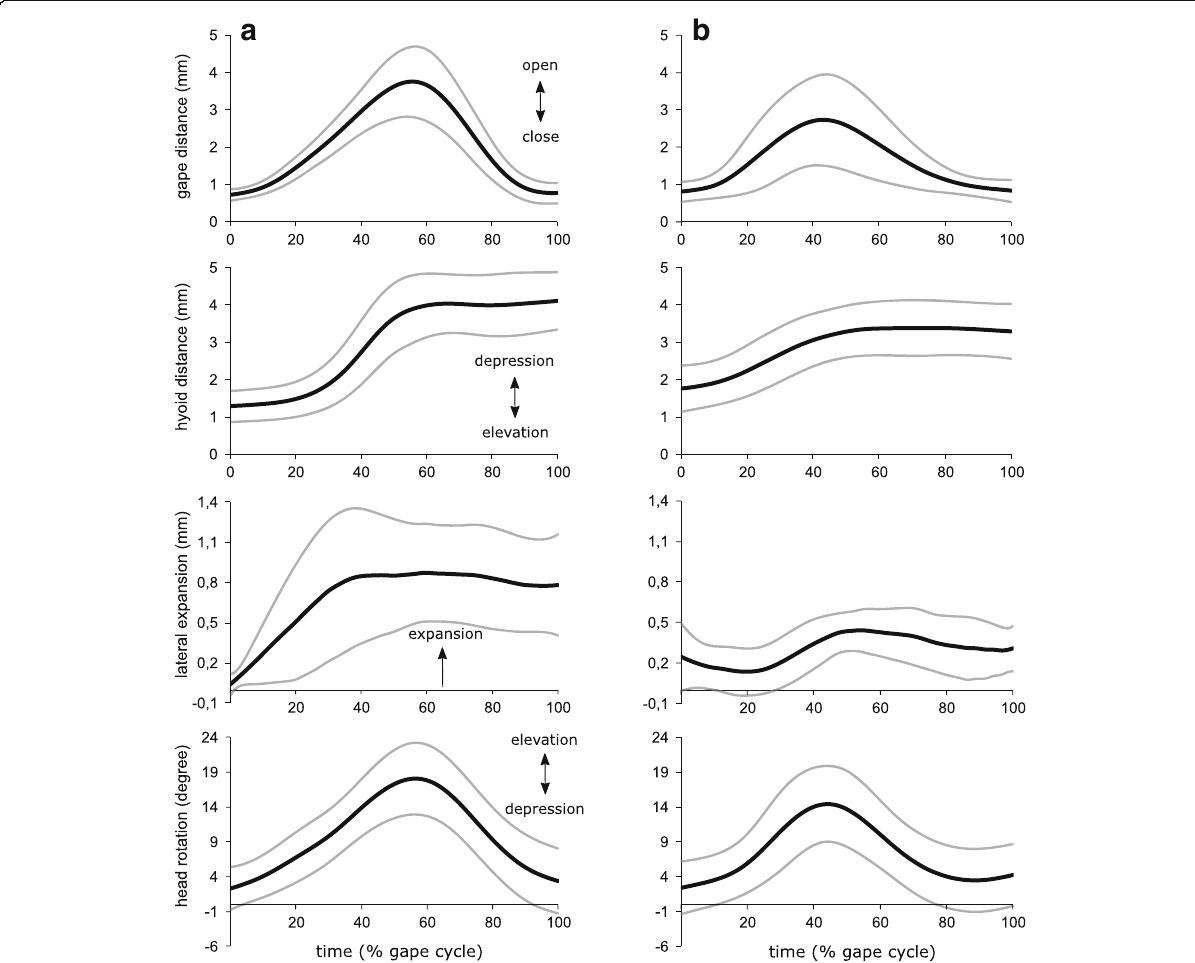
Fig. 3 Kinematic profiles showing gape, hyobranchium (hyoid), lateral head, and vertical head movements in metamorphic ( a ) and paedomorphic ( b ) Alpine newts. Bold and black lines indicate the mean values, while the grey and slender lines are ± standard deviation. The X-axes are normalized as percentage of total gape cycle